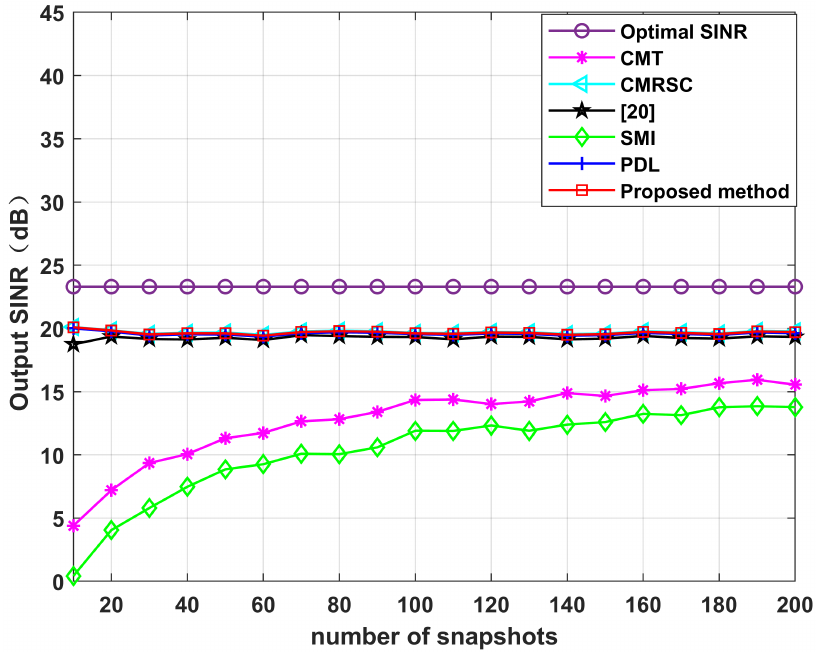
Figure 18. Output SINR versus the number of snapshots in the case of array geometry errors. Simulation